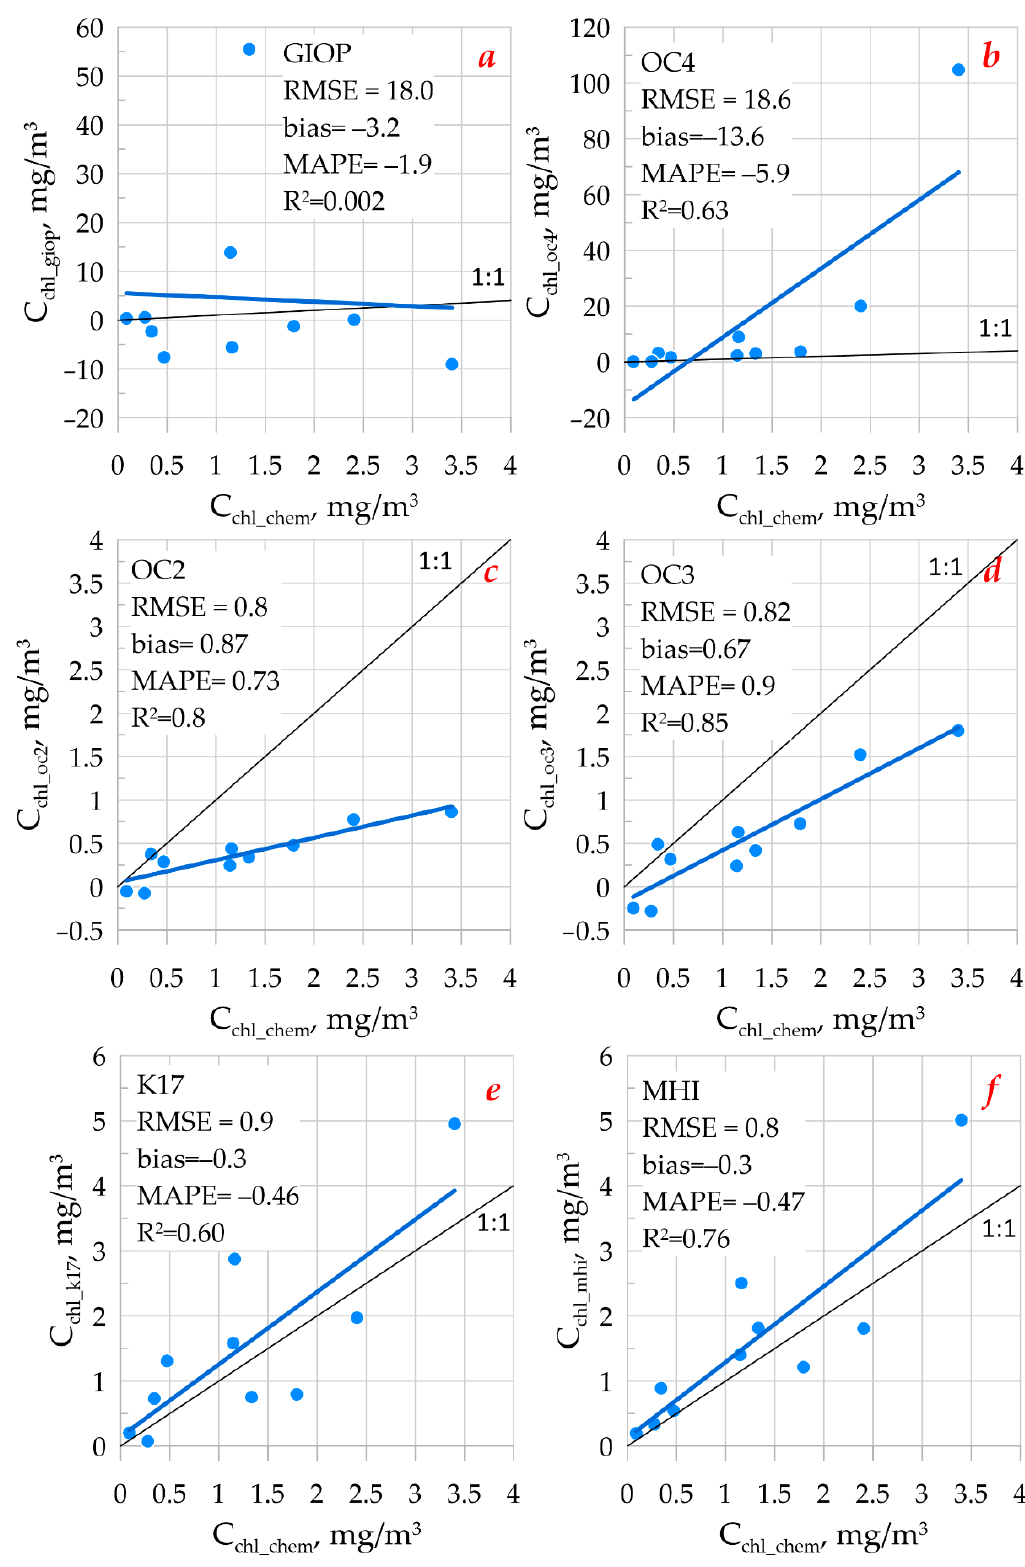
Figure 7. Comparison between measured ( 𝐶 𝑐ℎ𝑙_𝑐ℎ𝑒𝑚 ) and calculated chlorophyll-a concentration: ( a ) — GIOP; ( b ) — OC4v.6; ( c ) — OC2; ( d ) — OC3; ( e ) — K17; ( f ) — MHI algorithms.